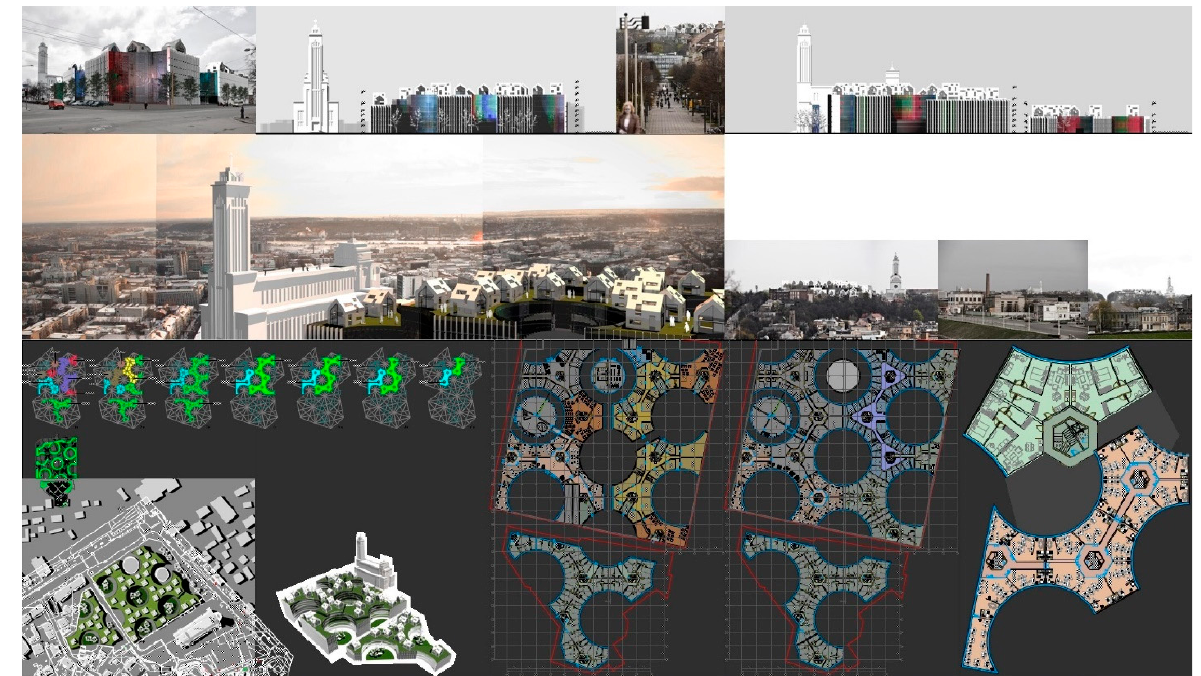
Figure 18. The presentation of the proposal “Žalias kalnas” (photo courtesy of Linas Tuleikis).